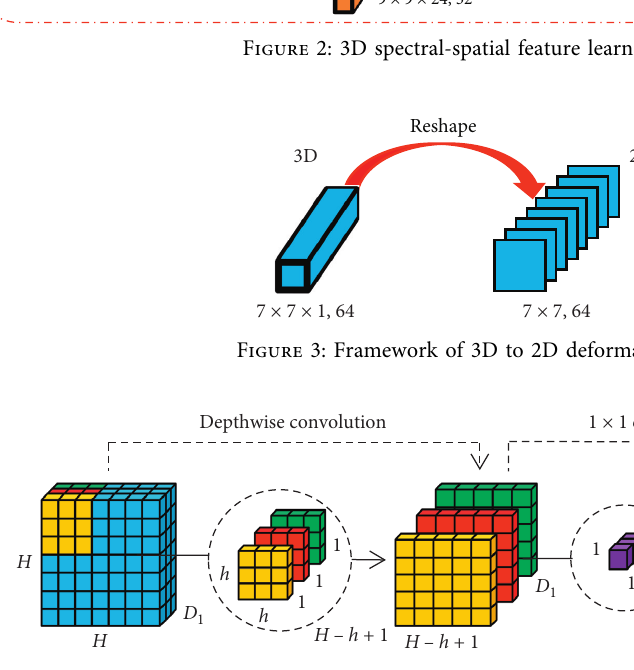
Figure 4: Depth-separable convolution.